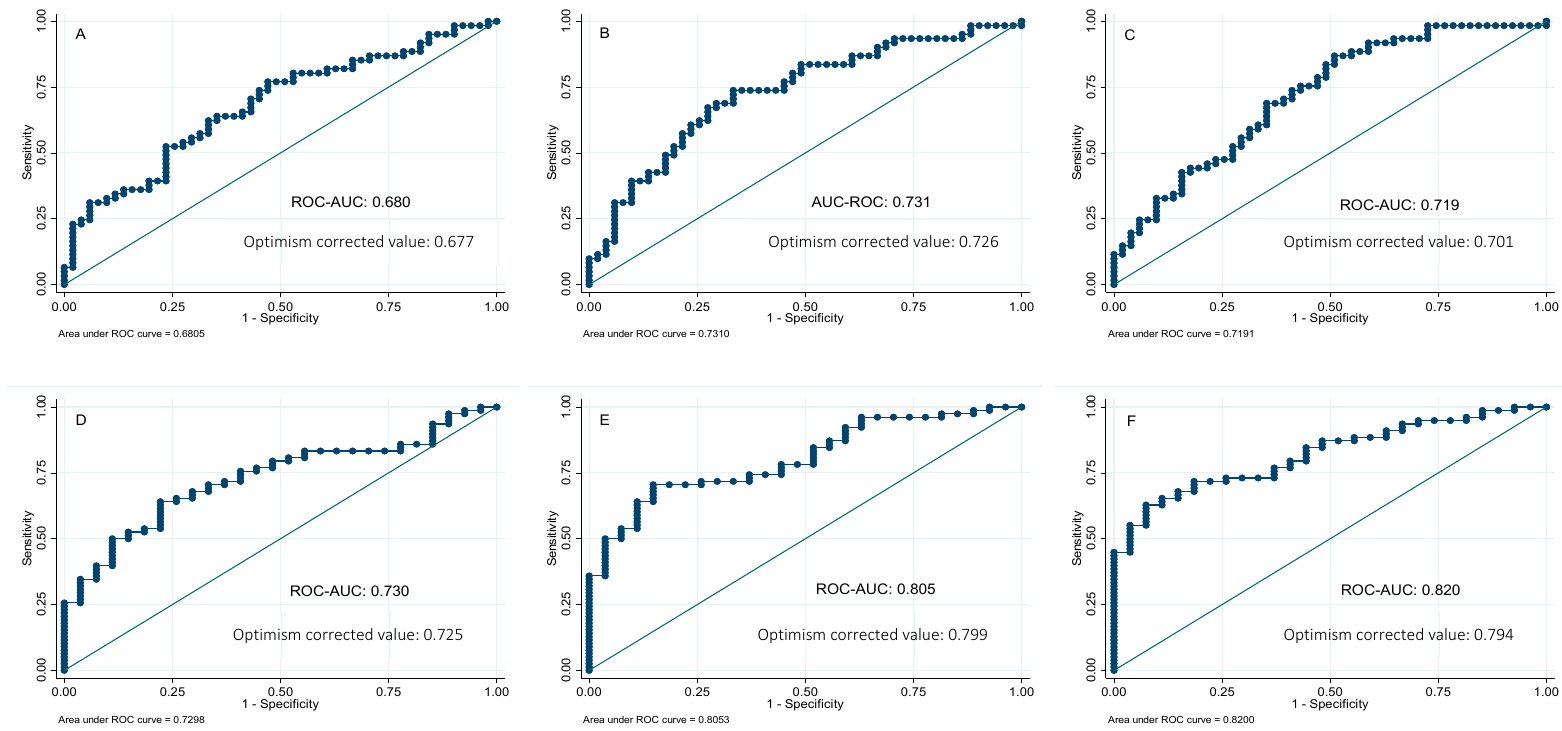
Figure 2. Receivers operating curves between liver iron percentage by magnetic resonance imaging (MRI) and ( A ) ferritin; ( B ) ferritin and ALT; ( C ) ferritin and triglycerides. Receivers operating curves between liver fat percentage by magnetic resonance imaging (MRI) and ( D ) ferritin; ( E ) ferritin and glucose; ( F ) ferritin, glucose, and ALT. AUC, area under the ROC curve. Reference line.